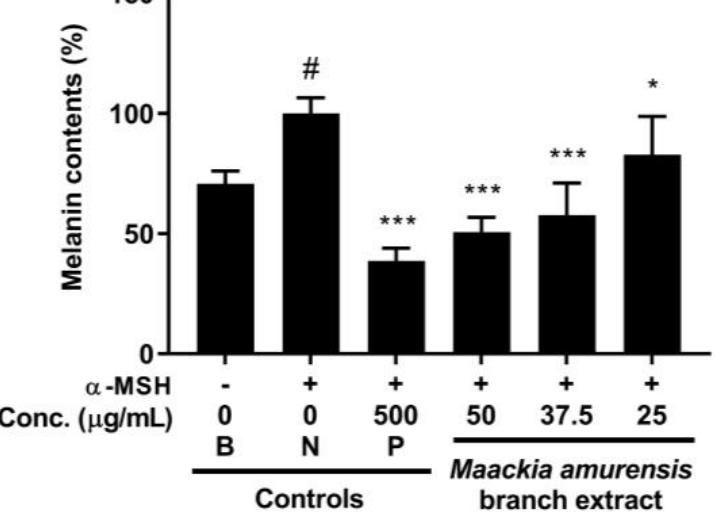
Figure 2. Effect of Maackia amurensis branch extract on α -melanocyte-stimulating hormone ( α - MSH)-induced melanin synthesis in B16F1 melanoma cells. B16F1 cells were treated with arbutin or